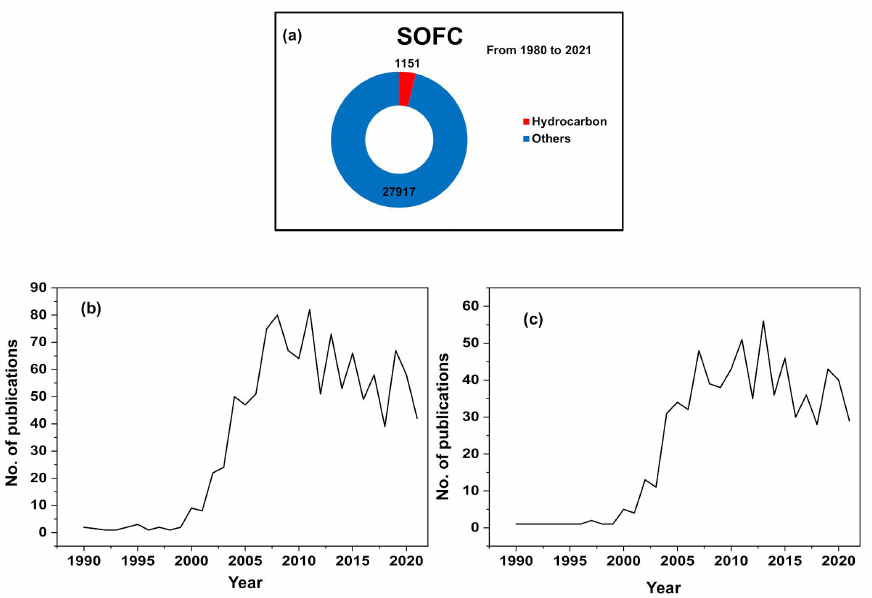
Figure 8. Scopus database analysis using keywords ( a ) SOFC, ( b ) SOFC+ HC, and ( c ) SOFC +HC+anode (data were acquired on 13 October 2021).